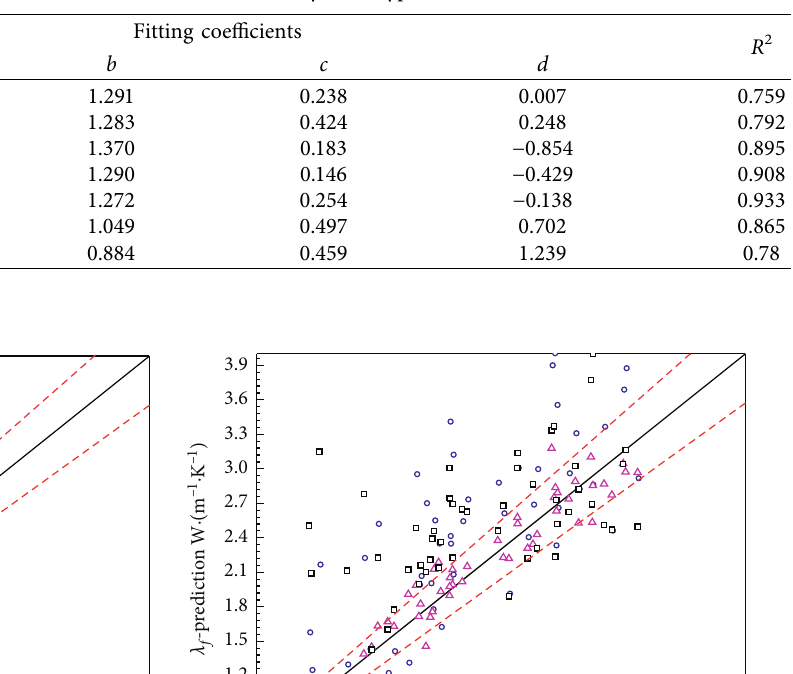
Table 3: Ternary fitting result of frozen soil thermal conductivity for 7 typical soils in the